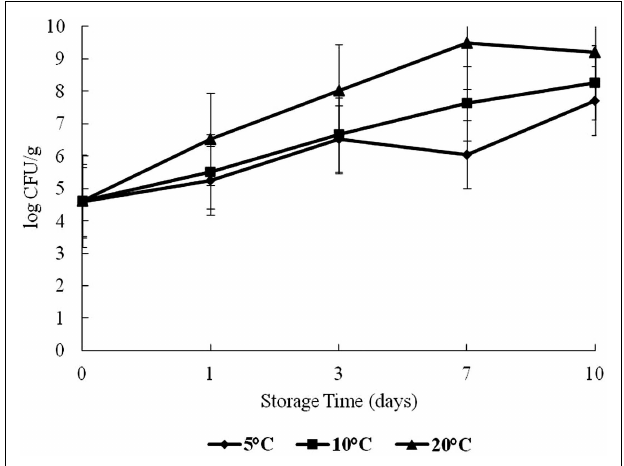
FIGURE 1 | Halophilic plate count (HPC) of oysters during a 10-day storage period at 5, 10, and 20°C .